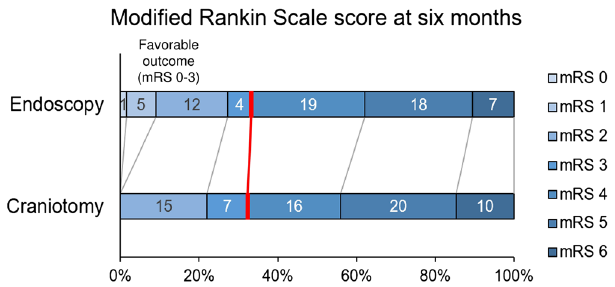
Figure 2. Modified Rankin Scale (mRS) score at 6 months after the surgery. Redline marks the division between the mRS scores 0–3 and 4–6. There was no significant difference between the mRS scores among the endoscopy and craniotomy groups at 6 months (Mann–Whitney U test; p = 0.29). No significant difference was observed in the distributions of the favorable and poor outcome favoring the endoscopy (Fisher’s exact test; p = 0.95, unadjusted odds ratio 0.957; 95% CI 0.465–1.971). The ordinal shift analysis using the ordinal logistic regression, after adjusting for age, hematoma location, Glasgow Coma Scale score on admission, history of stroke, and preoperative hematoma volume, did not reveal a significant shift of the mRS score at 6 months toward survival and independence by the endoscopic procedure ( p = 0.331, adjusted odds ratio 1.493; 95% CI 0.664–3.353).